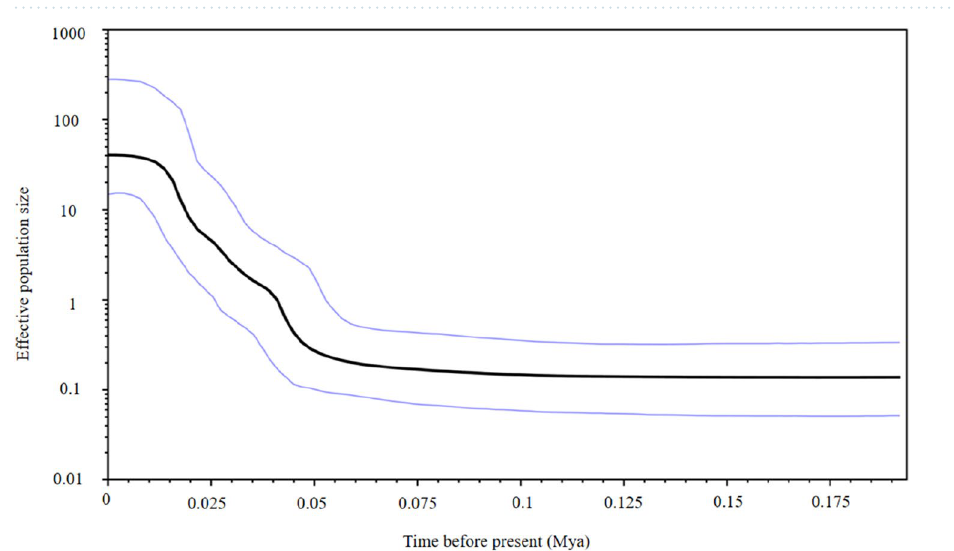
Figure 3. The minimum-spanning haplotype network inferred from the mitochondrial cyt b gene of Trichiurus nanhaiensis from seven geographic samples in mainland China. Each circle indicates each haplotype, and the size of each circle is related to its haplotype distribution frequency. Each color in haplotype network circles represents each geographic sample.